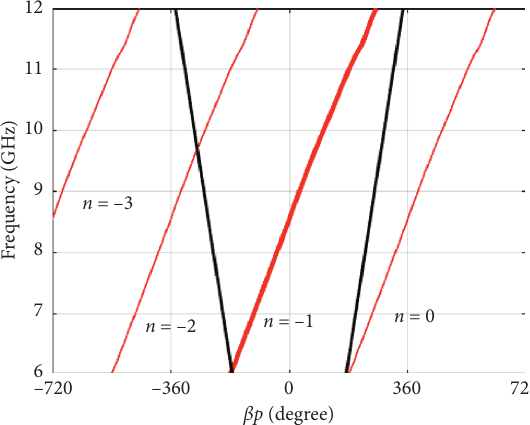
Figure 3: The dispersion diagram of proposed